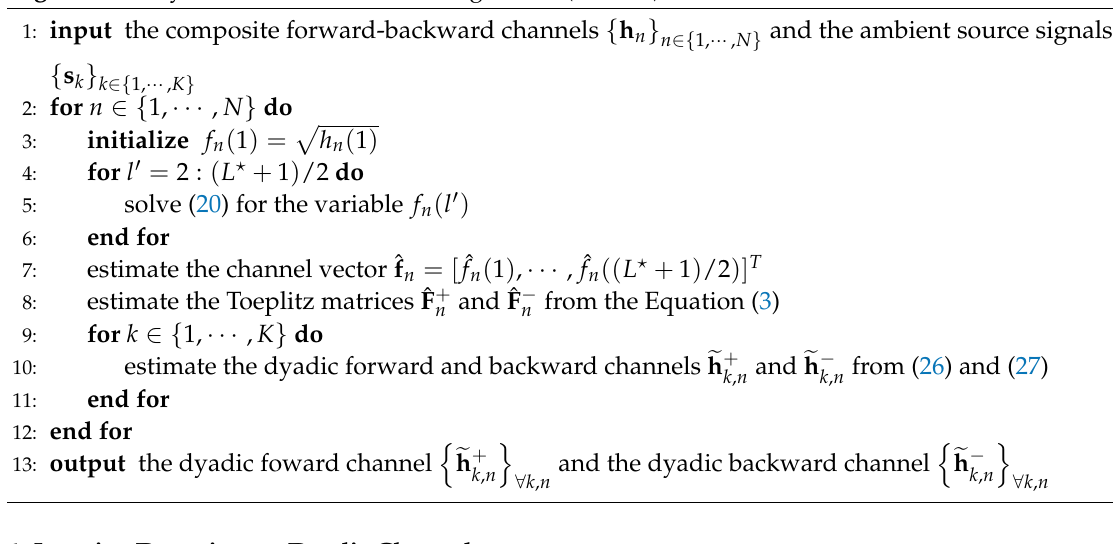
Algorithm 2 Dyadic channel estimation algorithm